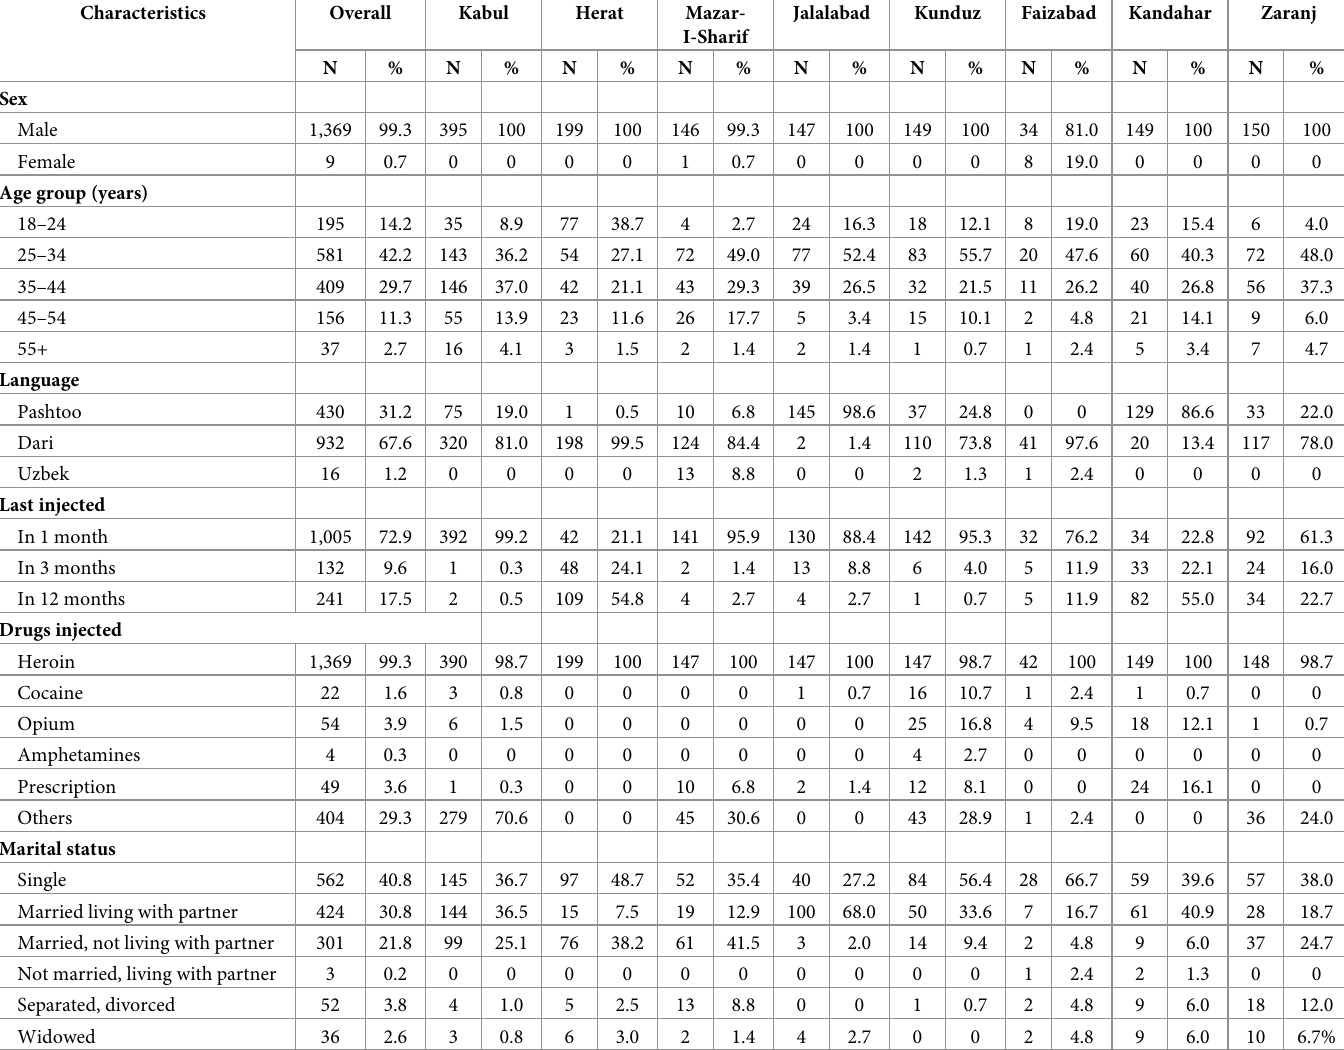
Table 5. Characteristics of people who inject drugs (PWID) who participated in the survey by city, Afghanistan, 2019.